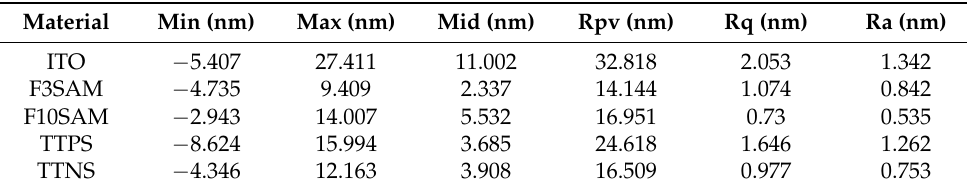
Table 1. Results of AFM measurements.